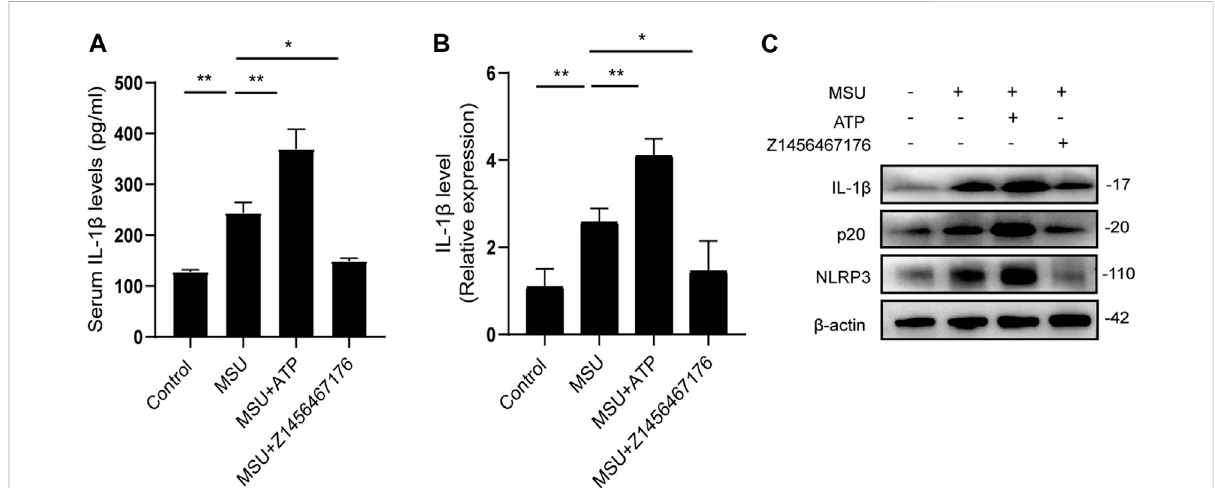
FIGURE. 7 Z1456467176 inhibits NLRP3 in fl ammasome activation in rat model of gout. (A) ELISA of serum IL-1 β levels in the four groups. (B) qPCR of IL-1 β genelevelsintheperipheralwholebloodcellsofratsineachgroup. (C) WBofNLRP3,p20,andIL-1 β expressioninthejointsandsurroundingsynovial tissues of rats in each group. Data are presented as the means ± S.E.M.s. Statistics were analyzed using Dunnett ’ s t test. n = 4. * p < 0.05; ** p < 0.01.